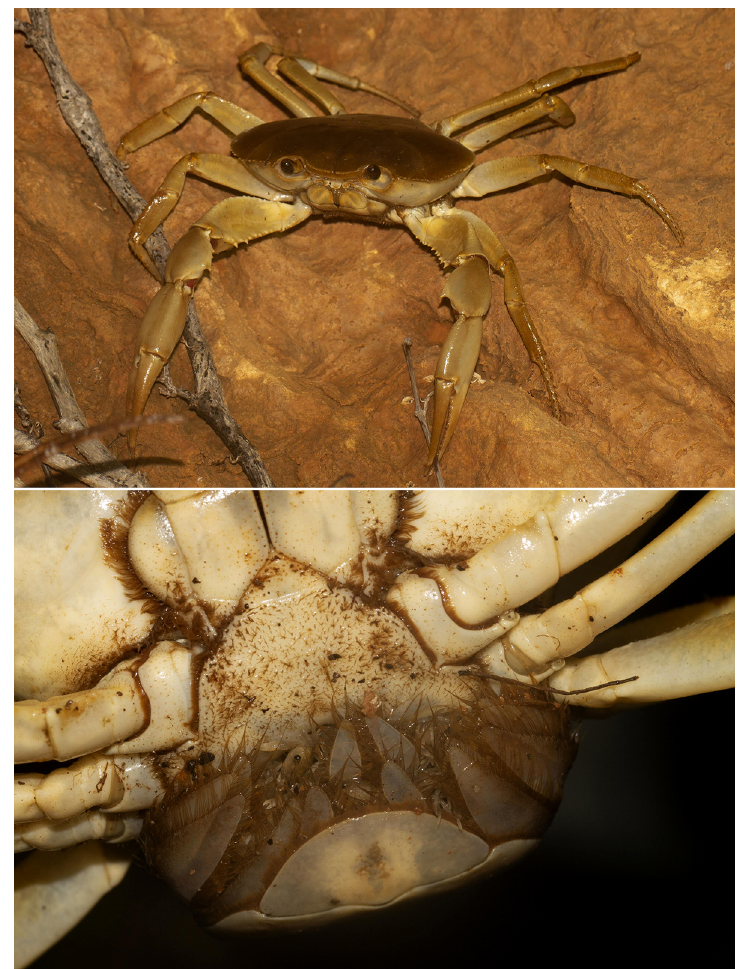
Figure 11. Adult female of Epilobocera capolongoi found carrying offspring in mountain rainforest on 5 October 2013, Pico San Juan Ecological Reserve, Cienfuegos province. Notice the very broad exopodite of the third maxilliped, which is a diagnostic character of this species. Photos by Ruben